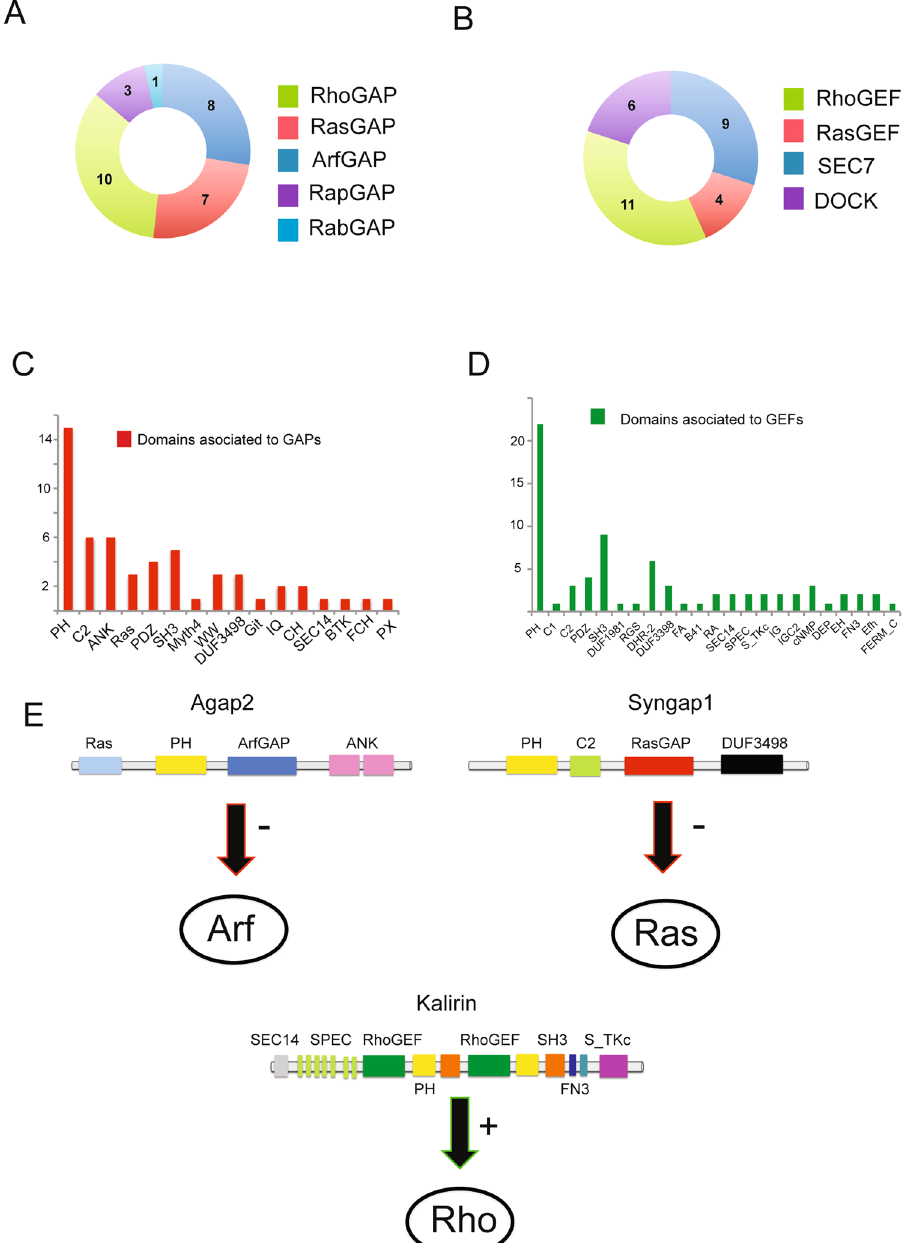
Figure 1. Distribution of GAPs and GEFs at the PSD. ( A ) Distribution of GTPase activating proteins (GAPs) at the postsynaptic density (PSD). ( B ) Distribution of guanine nucleotide exchange factors (GEFs) at the PSD. ( C ) Distribution of protein domain architecture of GAPs at the PSD. ( D ) Distribution of protein domain architecture of GEFs at the PSD. ( E ) Domain architecture of the GAP and GEF proteins used in this study. Abbreviations: ANK, Ankryin repeats; B41, Band 4.1 homologues; BTK, Bruton’s tyrosine kinase cys-rich motif; C1, protein kinase C conserved region 1 domain; C2, protein kinase C conserved region 2 domain; CH, Calponin homology domain; cNMP, Cyclic nucleotide-Monophosphate binding domain; DEP, domain found in disheveled, Egl-10, and Pleckstrin; DHR-2, Dock Homology Region 2; DOCK, Dedicator of cytokinesis; DUF, domain of unknown function; Efh, EF-hand, calcium binding motif; EH – Eps15 Homology domain; FA, FERM Adjacent; FCH, Fes/ CIP4 Homology domain; FERM_C, FERM C-terminal PH-like domain; FN3, Fibronectin type 3 domain; GAP, GTPase activator protein; GEF, Guanine nucleotide exchange factor; Git, Helical motif in the GIT family; IG, Immunoglobulin; IGC2 – Immunoglobulin C-2 Type; IQ, Calmodulin-binding motif containing conserved isoleucine (I) and glycine (Q) residues; Myth4. Domain in Myosin and Kinesin tails; PDZ, domain present in PSD-95, Dlg, and ZO-1/2; PH, Pleckstrin homology domain; PX, PhoX homologous domain; Ras, Ras subfamily of small GTPases; RGS, regulator of G-protein signaling; SEC14, domain in homologues of S. cerevisiae Sec14p; SEC7, domain in homologues of S. cerevisiae Sec7; SH3, Src Homology 3 domain; SPEC, Spectrin repeats; S_TKc, serine/threonine protein kinases catalytic domain; WW, domain with 2 conserved tryptophan (W)